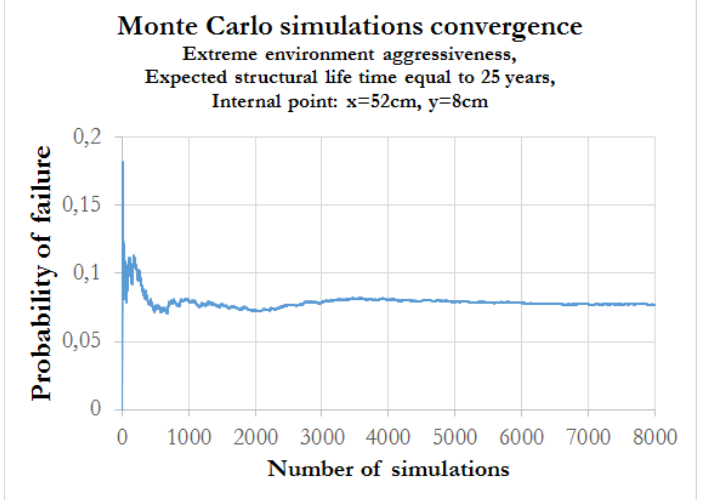
Figure 20 – Convergence analysis for x = 52 cm, y = 8 cm and t = 25